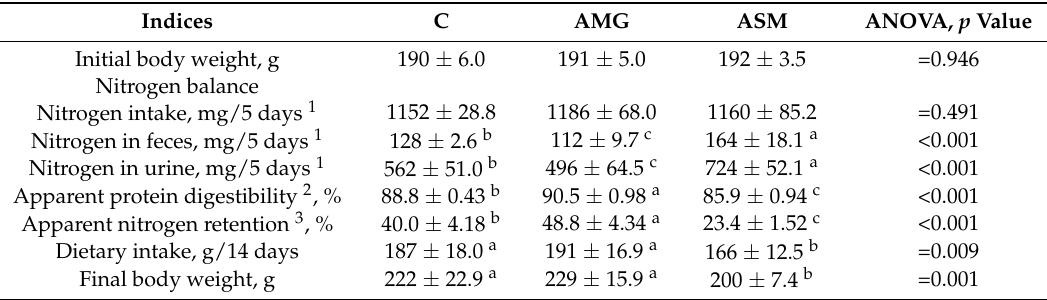
Table 2. Dietary intake, nitrogen balance and body weight of